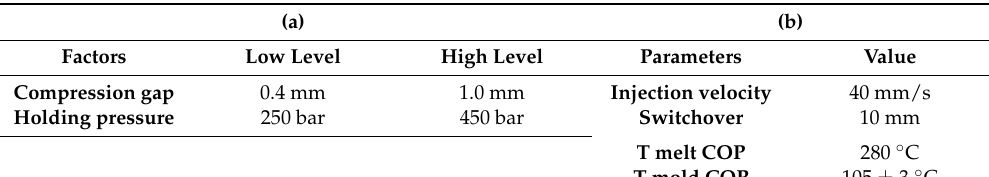
Table 5. Optimization experiment investigating the effect of compression gap and holding pressure in the ICM of the COP material: ( a ) with two factors on two levels; ( b ) constant